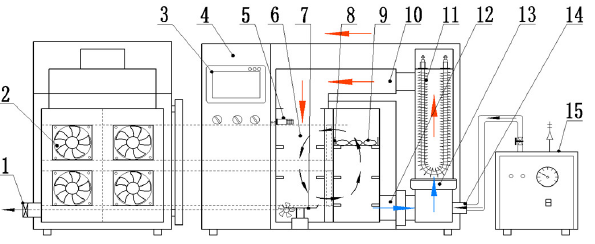
Figure 2. Schematic diagram of temperature and humidity controlled hot air dryer (The arrows indicate the direction of airflow). (1) Dehumidification axial fan, (2) disturbing fan, (3) touch screen, (4) control cabinet, (5) temperature and humidity sensor, (6) drying chamber, (7) weighing module, (8) material tray, (9) samples, (10) air bellows assembly, (11) electric heating tube, (12) return air duct, (13) axial flow fan, (14) steam inlet, (15) steam generator.